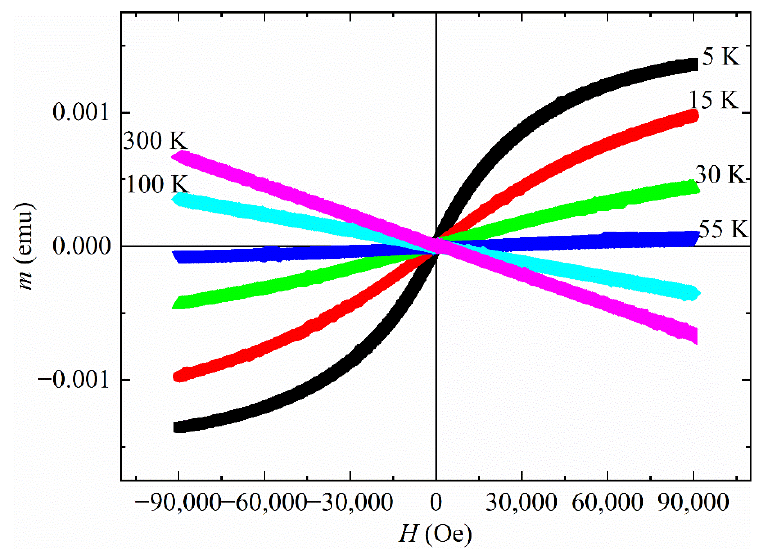
Figure 1. m ( H ) curves at different temperatures.